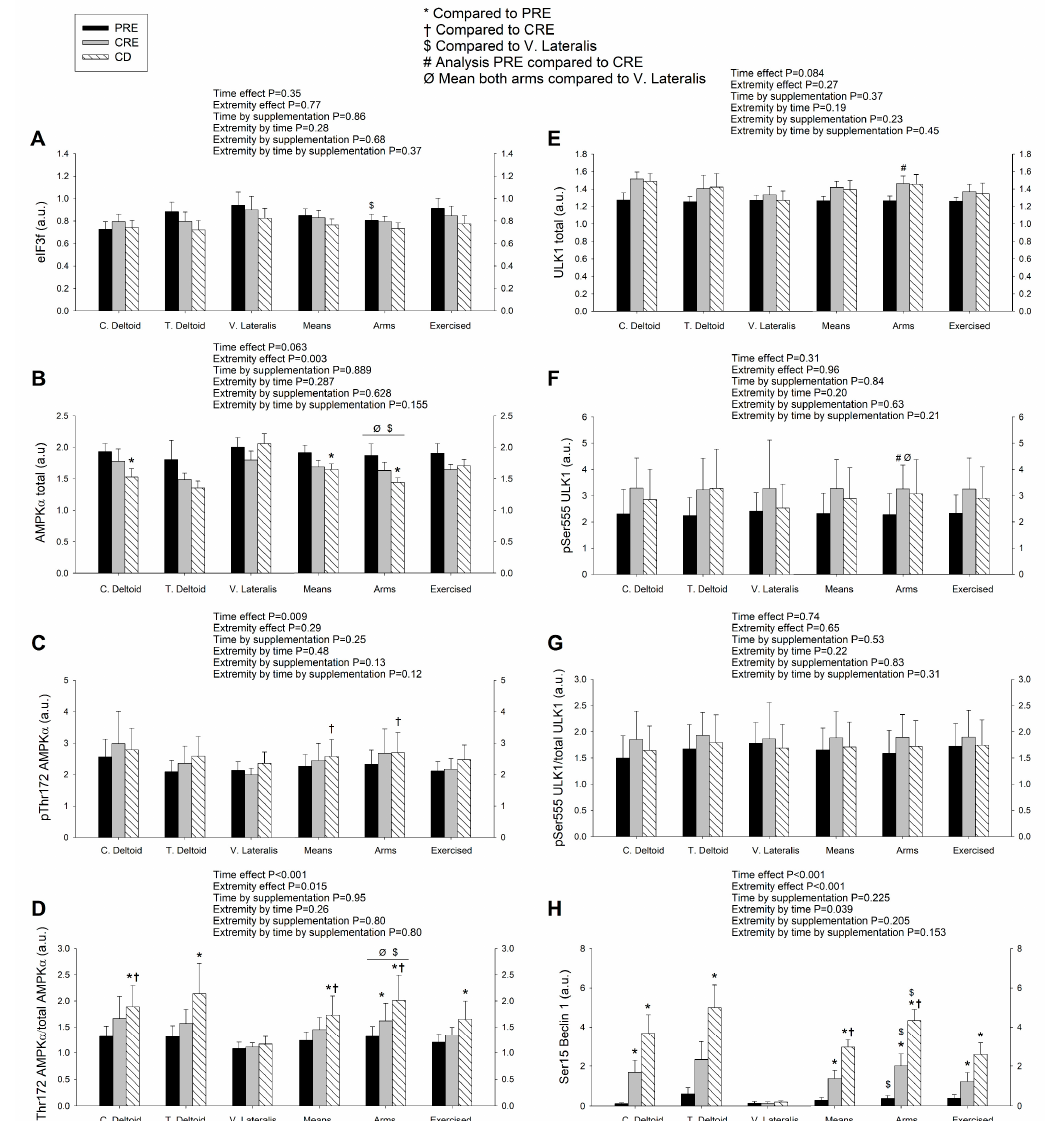
Figure 3. A high volume of exercise prevents the phosphorylation Thr172 AMPK, Ser555 ULK1, and Ser15 Beclin 1 in skeletal muscle, blunting the autophagic response and preserving lean mass during a severe energy deficit. Protein expression levels of eIF3f ( A ); total and phosphorylated AMPK α ( B – D ), and ULK1 ( E – G ) and the corresponding fractional phosphorylation ratios, and phosphorylated Beclin 1 ( H ) in skeletal muscle following the three experimental phases. The various phases of the intervention are explained in Figure 1. PRE, before the intervention; CRE, caloric restriction and exercise; CD, control diet; C. Deltoid, control deltoid; T. Deltoid, trained deltoid; V. Lateralis, vastus lateralis; Means, (C. Deltoid + T. Deltoid + vastus lateralis) / 3; Deltoid muscles, (C. Deltoid + T. Deltoid) / 2; Exercised, (T. Deltoid + vastus lateralis) / 2. n = 7 and n = 8 for the sucrose and whey protein groups, respectively. The statistical analysis was performed with logarithmically transformed data for all proteins. The values shown are means ± standard errors and expressed in arbitrary units (a.u.). *, p < 0.05 compared to PRE; † , p < 0.05 compared to CRE; $ , p < 0.05 compared to vastus lateralis; # , p < 0.05 PRE compared to CRE (only PRE and CRE conditions included in the ANOVA); and Ø , p < 0.05 mean both deltoid compared to vastus lateralis.